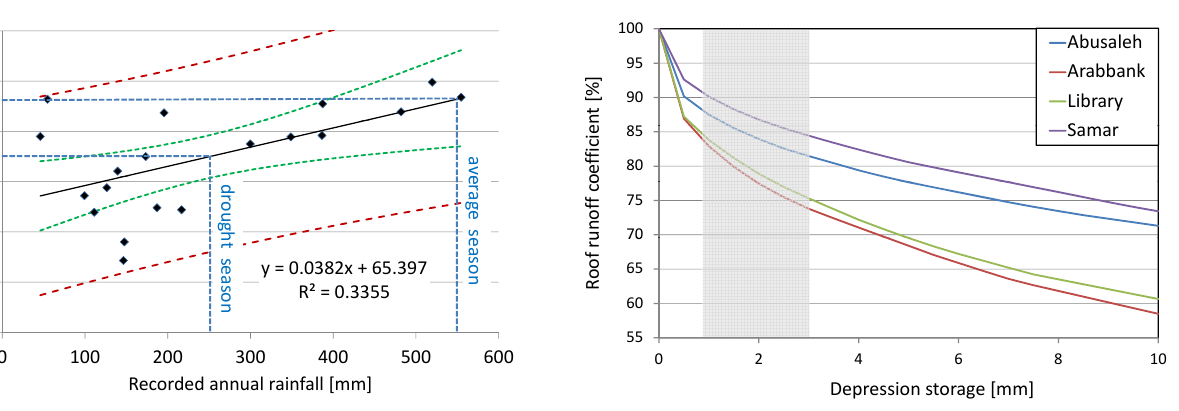
Fig. 6. Calculated RCs for different values of maximum roof de- pression storage DS; the shaded area (1–3mm) represents the antic- ipated uncertainty range accounting for different roof types; rainfall of season 1999/2000 is used as